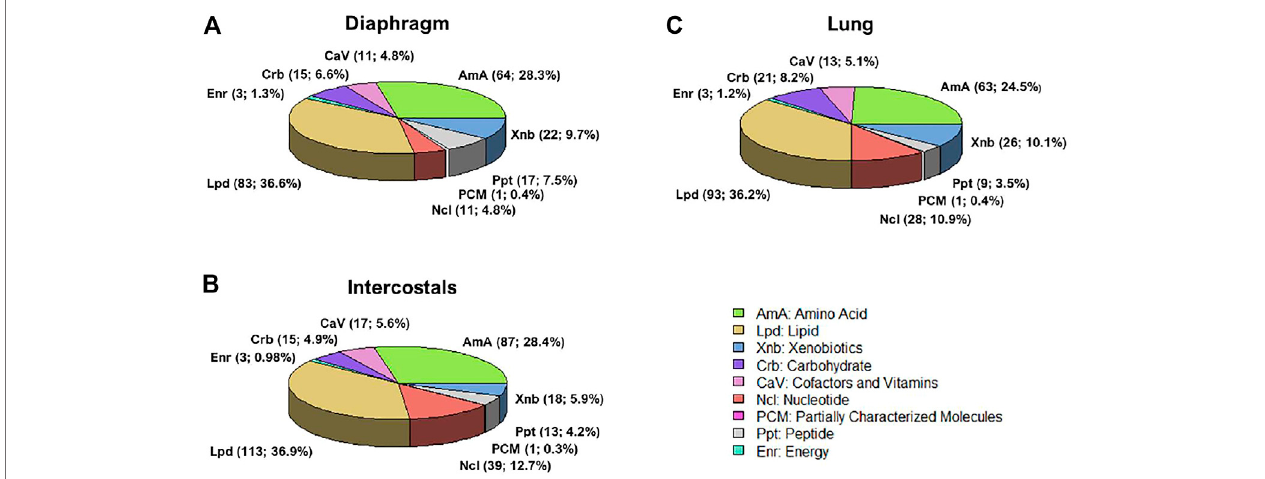
FIGURE 2 | Differential metabolites classi fi cation in (A) diaphragm, (B) intercostals, and (C) lung tissue. According to the Metabolon annotation list, there are nine categories, including Amino Acid (AmA), Cofactors and Vitamins (CaV), Carbohydrate (Crb), Energy (Enr), Lipid (Lpd), Nucleotide (Ncl), Partially characterized molecules (PCM), Peptide (Ppt), Xenobiotics